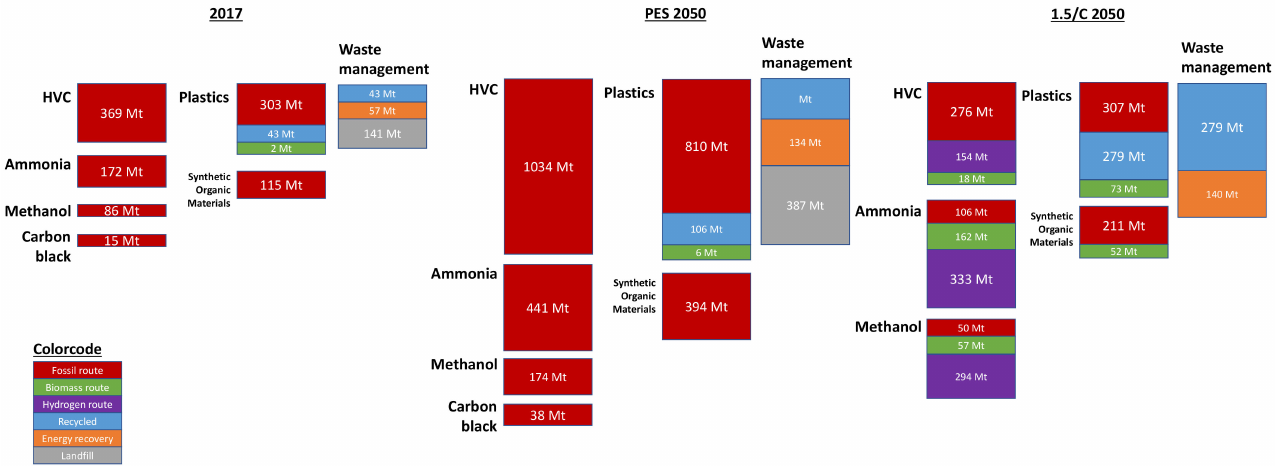
Figure 2. Estimated production volumes of the key chemicals,